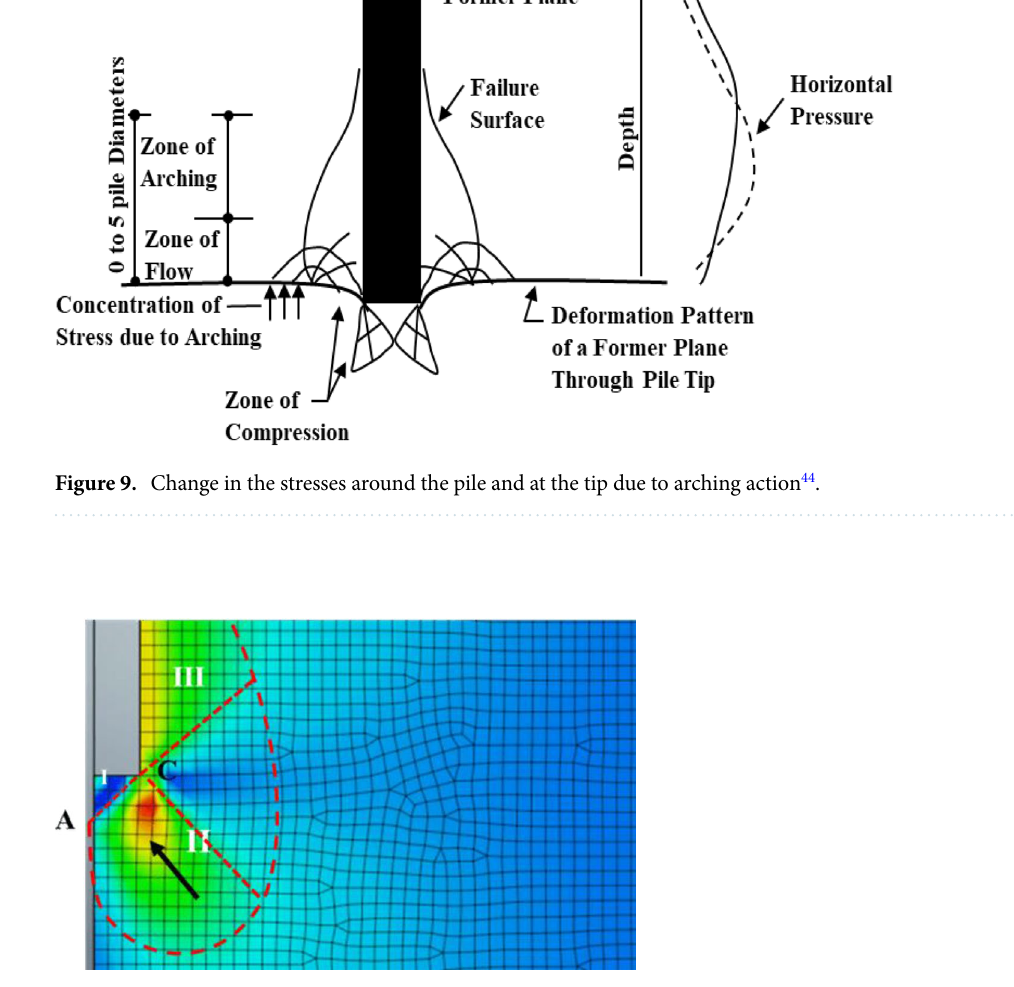
Figure 10. Shear stress distribution around the LDBP base at the failure state.